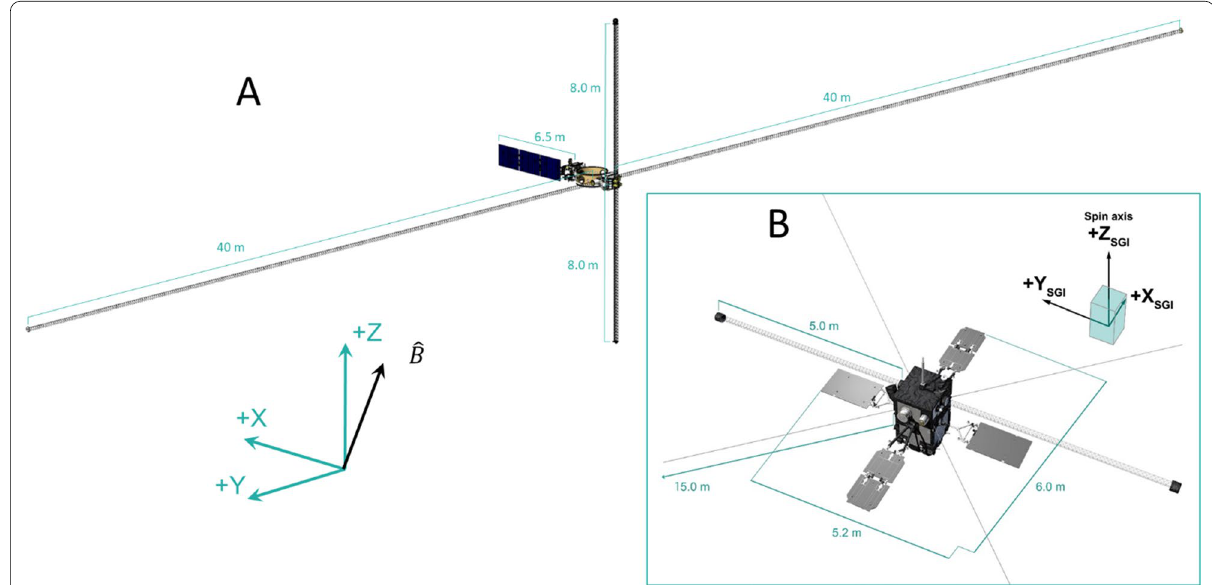
Fig. 1 The DSX and Arase spacecraft and their fixed coordinate frames. A The DSX spacecraft consists of a payload module affixed to one side of an ESPA (Evolved Expendable Launch Vehicle Secondary Payload Adapter) bus and an avionics module on the opposite face. The VLF antenna has two 40 m booms used as an effective 80 m dipole along the spacecraft Y‑axis. During transmission, DSX maintained an orientation relative to the geomagnetic field B as shown (with Y perpendicular to B ). B The Arase spacecraft has a full suite of particle and field instruments for observing + the inner magnetosphere. While DSX is 3‑axis stabilized, Arase spins about its Z‑axis as indicated in Spinning‑satellite Geometry Inertia